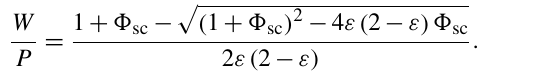
(cid:17) (cid:16) W versus the soil storage index P (scheme W